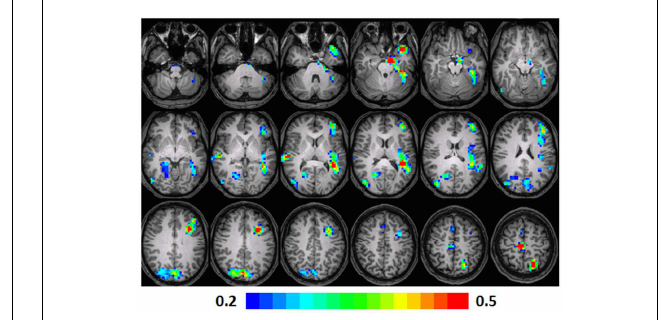
FIGURE 6 | Regression maps showing a positive correlation for activation during verb generation scans fromT3 and the Letter–Word score from theWoodcock–Johnson III ( N = 15) atT3. The activated pixels meet significance at p < 0.001, uncorrected, higher significance is indicated by hotter color. Slices range from z = 7 to 24 in theTalairach frame. Cluster size is 35 voxels. Higher significance is indicated in hotter color ( r value ranged from 0.2 to 0.5). Figure is presented in a radiological orientation (L = R, R =